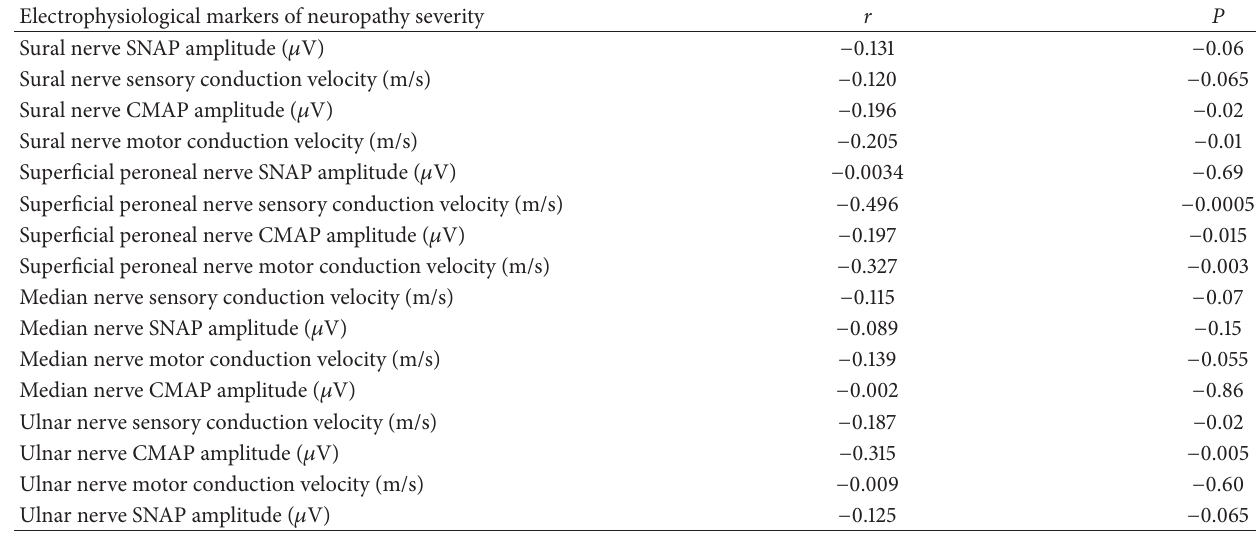
Table 4: The correlation analysis between urinary methylmalonic acid/creatinine and electrophysiological markers of neuropathy severity. Electrophysiological markers of neuropathy severity r P Sural nerve SNAP amplitude ( 𝜇 V) − 0.131 −